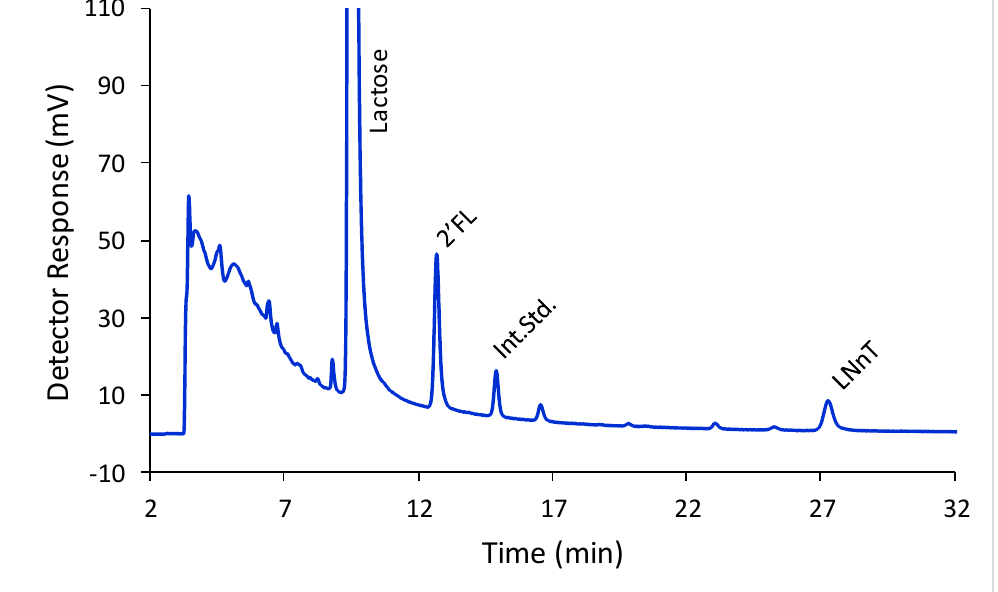
Figure 2. Separation of 2 ′ -fucosyllactose (2 ′ -FL) and Lacto-N-neotetraose (LNnT) from each other and from lactose in infant formula by HILIC-FLD, using laminaritriose as an internal standard (Int. Std.).